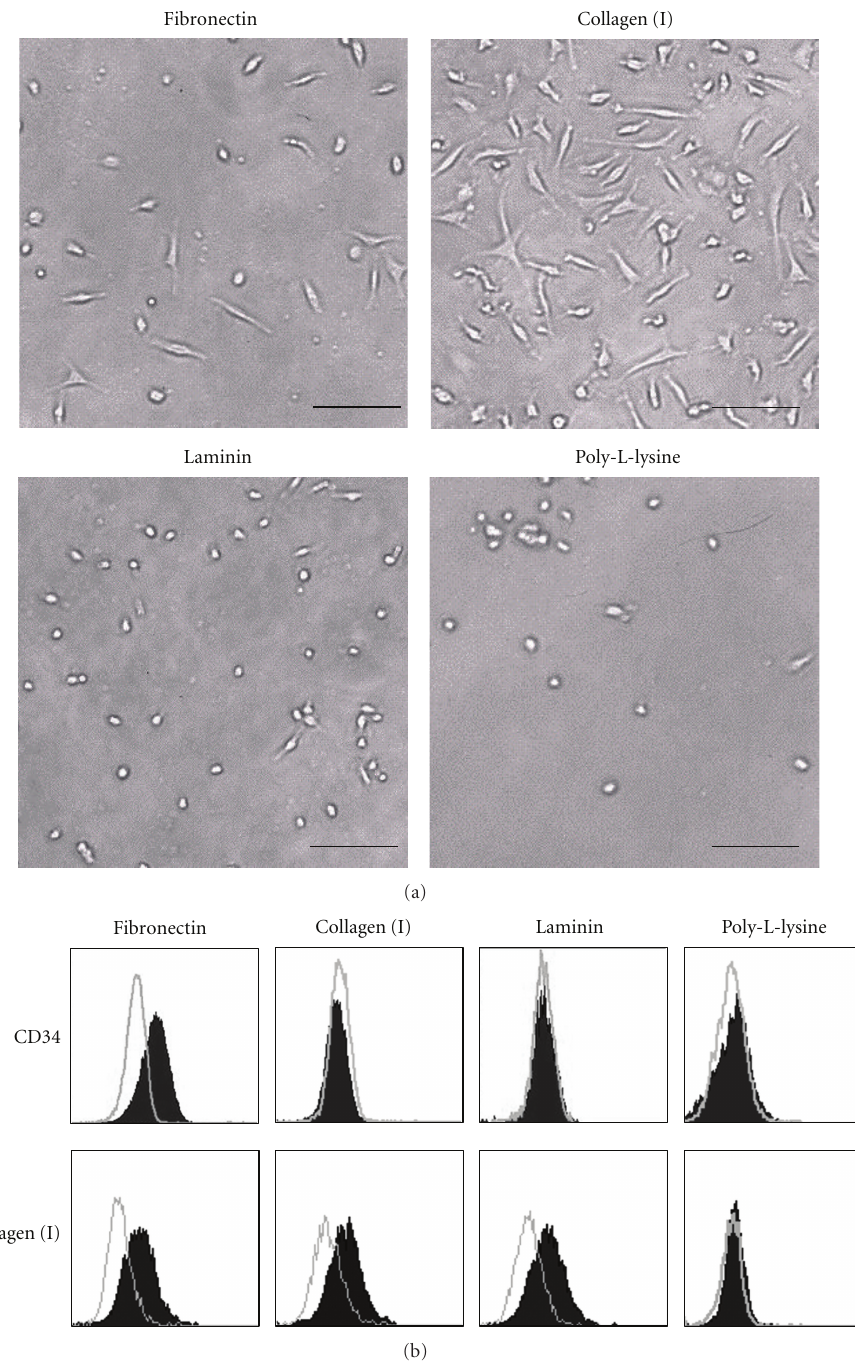
Figure 1: MOMC generation cultures on fibronectin, collagen (I), and laminin, or poly-L-lysine. (a) PBMCs (2 × 10 6 ) were cultured for 7 days on 24-well plastic plates coated with fibronectin (Sigma), collagen (I), laminin, or poly-L-lysine. The medium containing floating cells was exchanged with fresh medium every 3 days. The adherent cells were observed with an inverted microscope. Bars: 100 μ m. (b) Adherent cells recovered were subjected to flow cytometry for evaluation of cell surface expression of CD34 and intracellular expression of collagen (I). The expression of CD34 and collagen (I) is shown as shaded histograms, while open histograms represent staining with isotype-matched control mAb. The results shown are representative of 5 independent